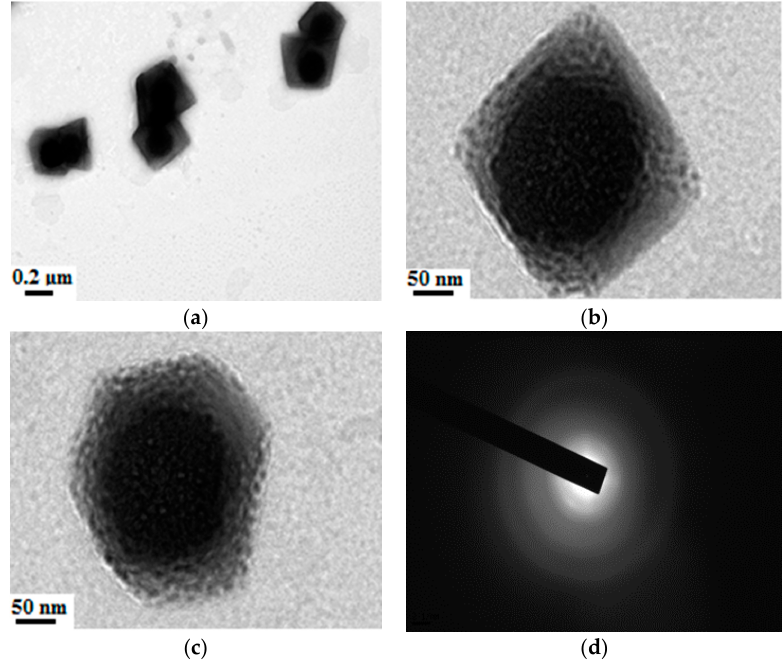
Figure 5. TEM spectra of organic-inorganic super hydrophobic nanocomposite emulsion at 80 °C. ( a ) Tetrahedral particle; ( b ) cube particle; ( c ) octahedral particle; and ( d ) diffraction pattern.